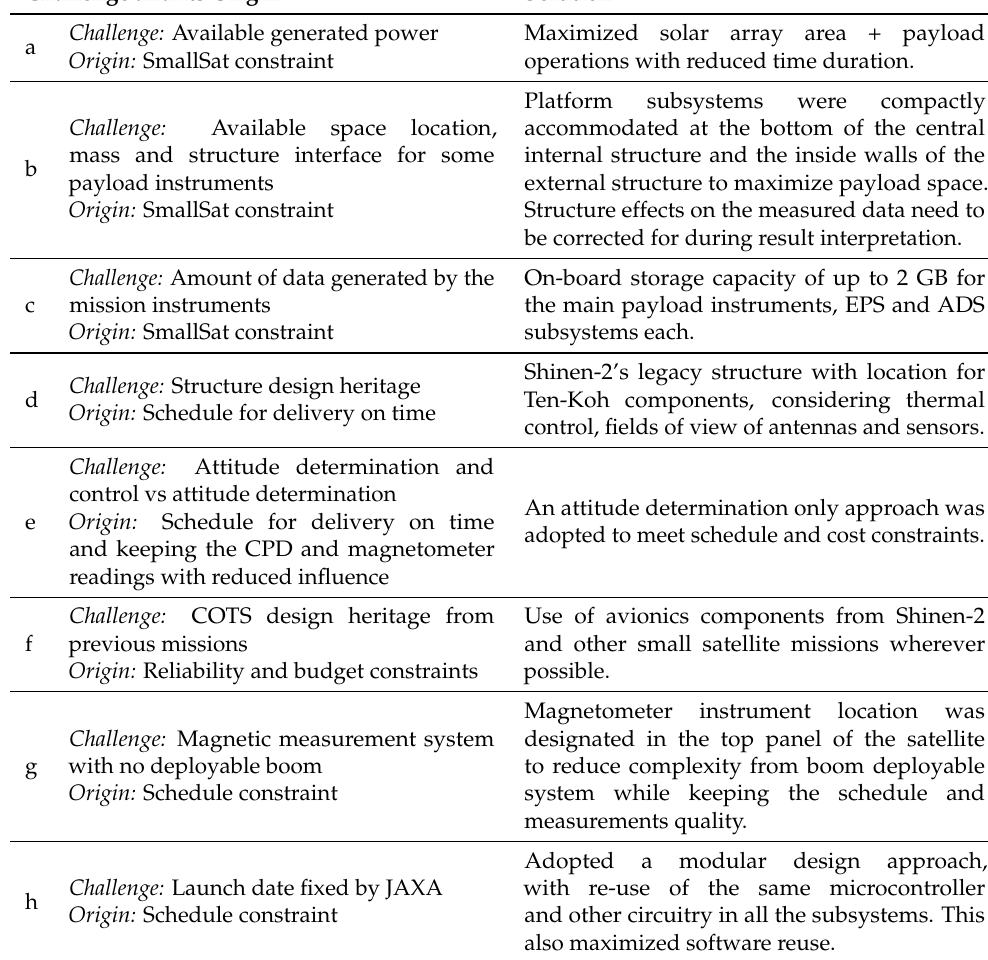
Table 3. Design challenges and adopted